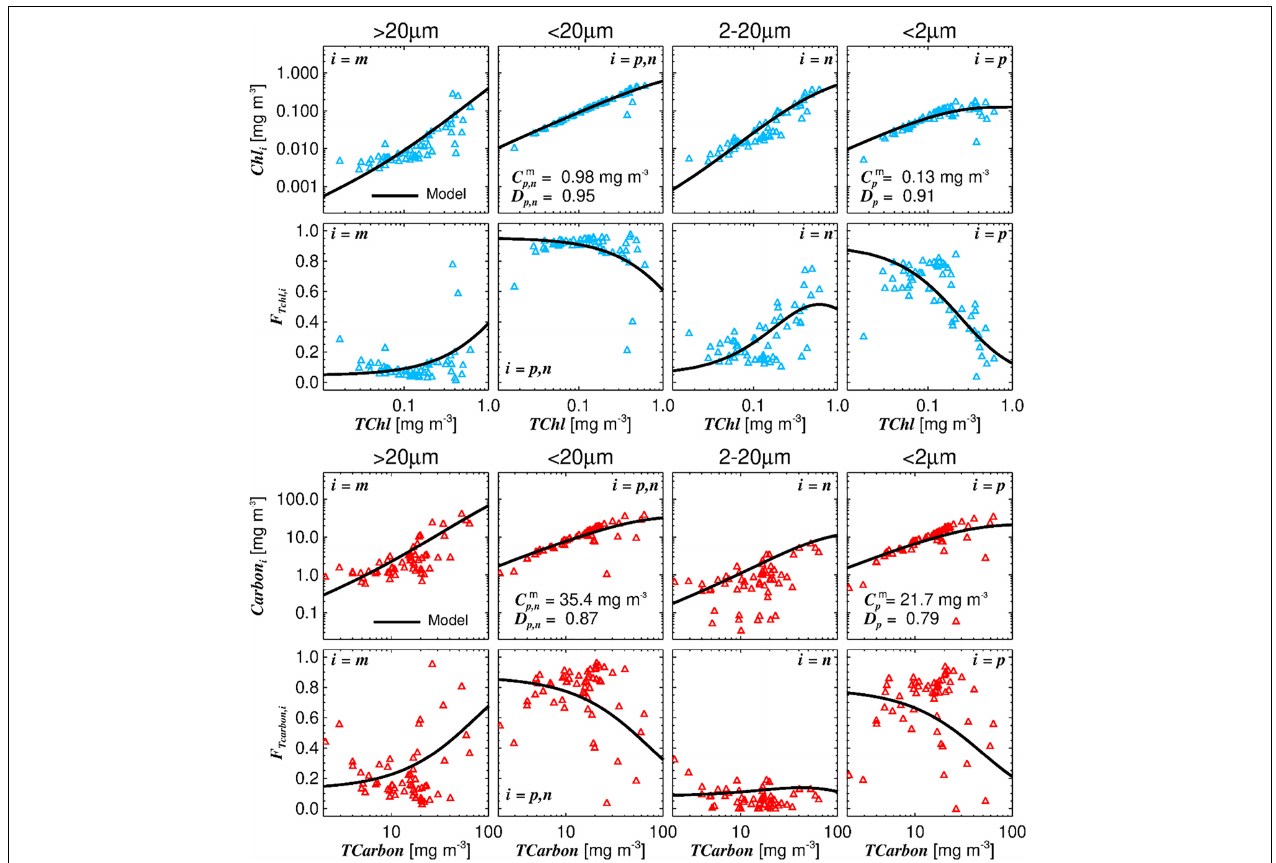
FIGURE 7 | Three component model applied to TChl a and TCarbon. Top row: the three component model fitted to chlorophyll- a values associated with the different size classes: microplankton (Cm), picoplankton, and nanoplankton combined (Cp,n), nanoplankton by itself (Cn), and picoplankton by itself (Cp); Dp,n and Dp reflect the fraction contributed by size-class pico and pico+nano to TChl a as TChl a tends to zero. Second row: the size-specific fractional contributions of microplankton (Fm), nano+picoplankton (Fn,p), nanoplankton (Fn), and picoplankton (Fp), plotted according to the model as a function of total Chl a . Third row: the model applied to TCarbon values (assessed by cell enumeration converted into carbon) associated with class 5 (im), classes 2, 3, 4 (in), and class 1 (ip) (see Table 1 ). Fourth row: size-specific fractional contributions to Fm, Fn,p, Fn, Fp, obtained from the carbon